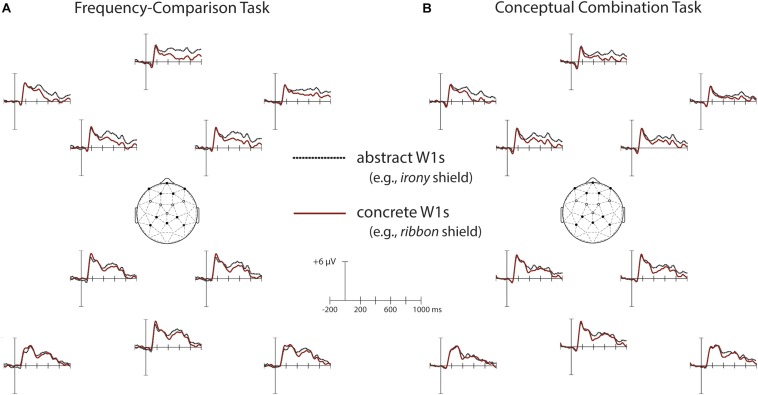
Grand average ERPs to concrete (e.g., “ribbon”) and abstract (e.g., “irony”) first words (W1s). Waveforms are shown from ten electrode sites, which comprise the anterior frontal and parietal clusters submitted to statistical analyses (see section Materials and Methods). Electrode positions are indicated on the head diagrams with solid black dots. The hollow black dots represent the frontocentral electrode cluster, which was also analyzed. (A) ERPs for W1s in the frequency-comparison task; (B) ERPs for W1s in the conceptual combination task. Significant N400 and N700 word-level concreteness effects were present in both tasks.